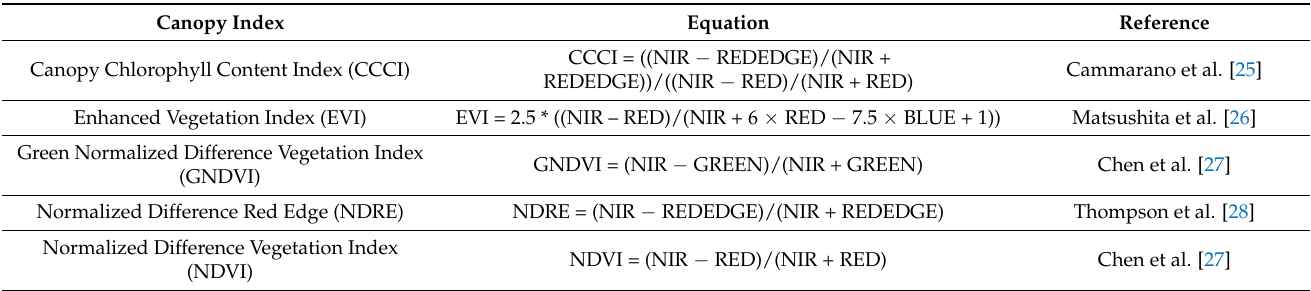
Table 2. Construction of selected indices analysis of winter wheat